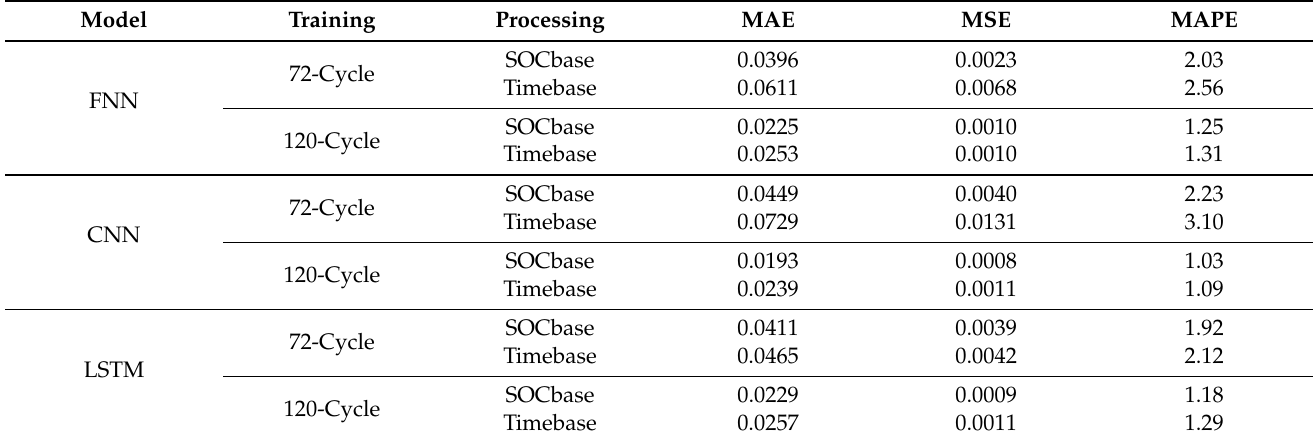
Table 4. Estimation errors in various models and training cycles.